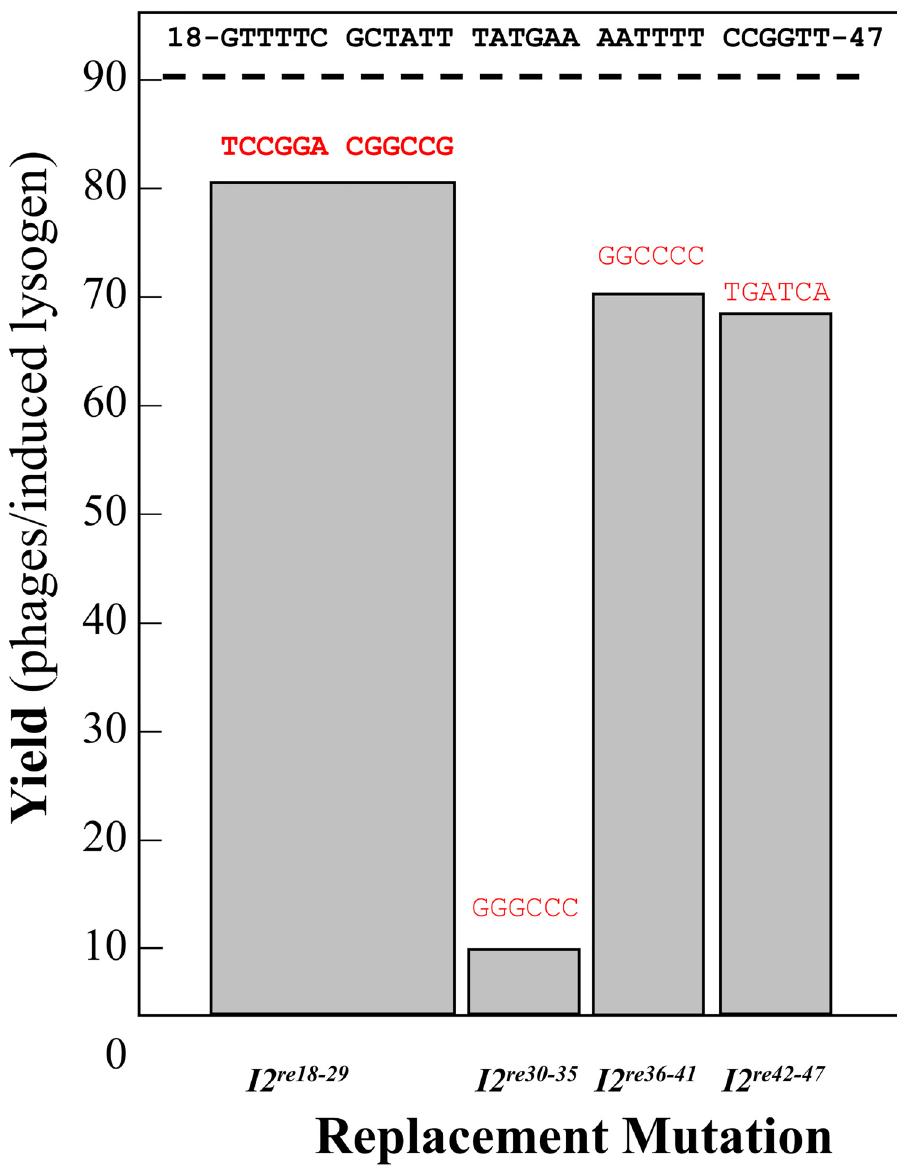
Fig 2. Effect of I2 re mutations on virus yield. Lysogens of λ -P1 I2 + and the I2 re mutants were induced and the phage yields in the resulting lysates were determined. The I2 + sequence is shown at the top of the figure in black. The sequences of the replacement mutations are in red. For the lethal I2 re30-35 mutant, the kanamycin-transducing titer was determined. The large I2 re18-29 mutation was used because an earlier study with 6 bp-long mutations indicated that the entire segment could be replaced without affecting virus growth. These data are from a single experiment; a repeat experiment gave equivalent